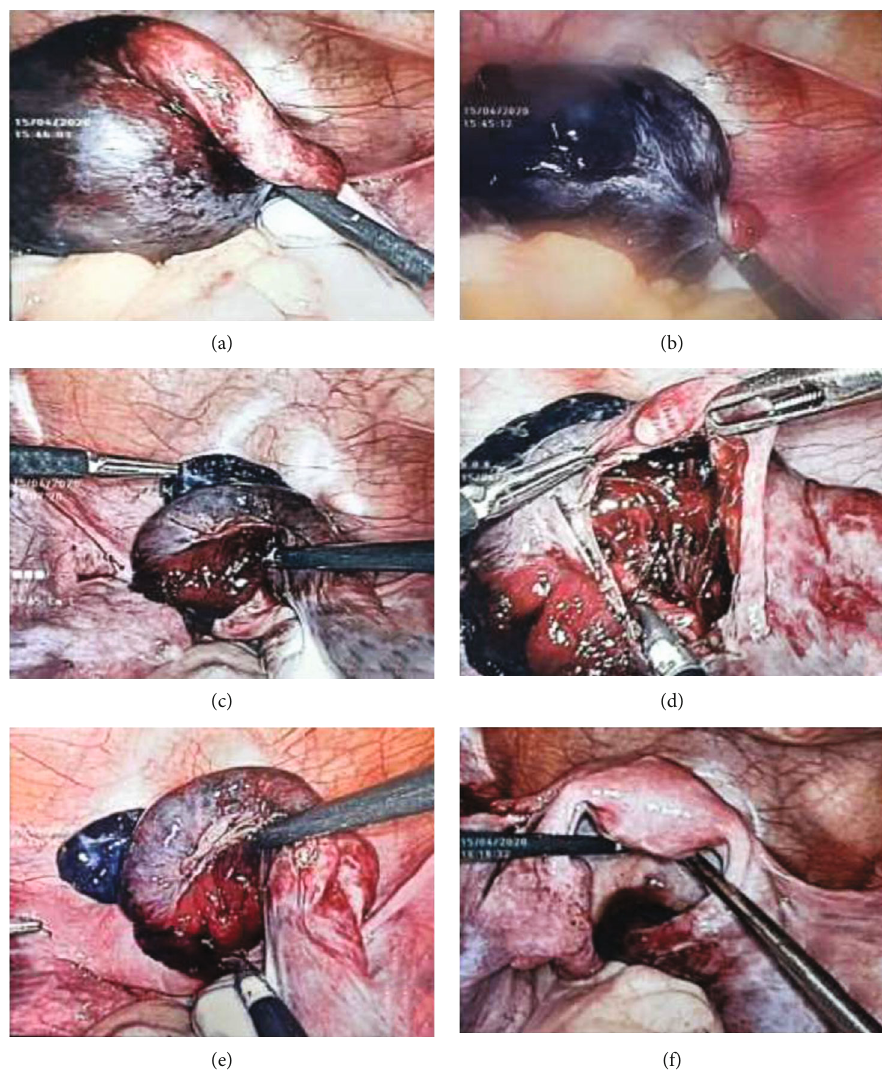
Figure 2: Sequential changes in the ovarian and tubal tissues in the teenager related to the case